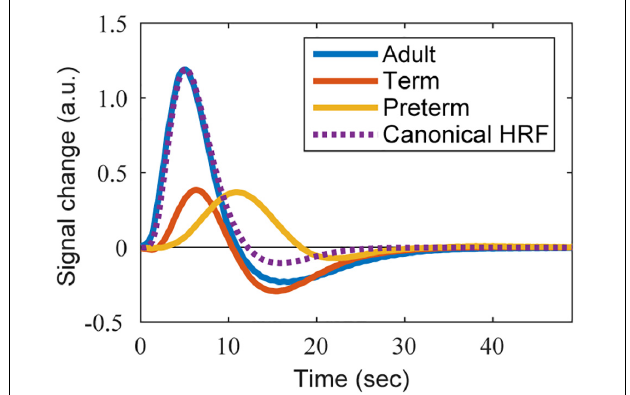
FIGURE 2 | The shape of HRFs used in the simulation. The BOLD-based HRFs estimated from the BOLD responses reported in Arichi et al. (2012) are presented. Adapted from Arichi et al. (2012), with permission from Elsevier. Blue, red, and orange lines correspond to the HRFs of an adult, term infant, and preterm infant, respectively. The purple dotted line is the reference shape of the adult’s canonical HRF, whose height is adjusted to that of the estimated adult’s BOLD-based